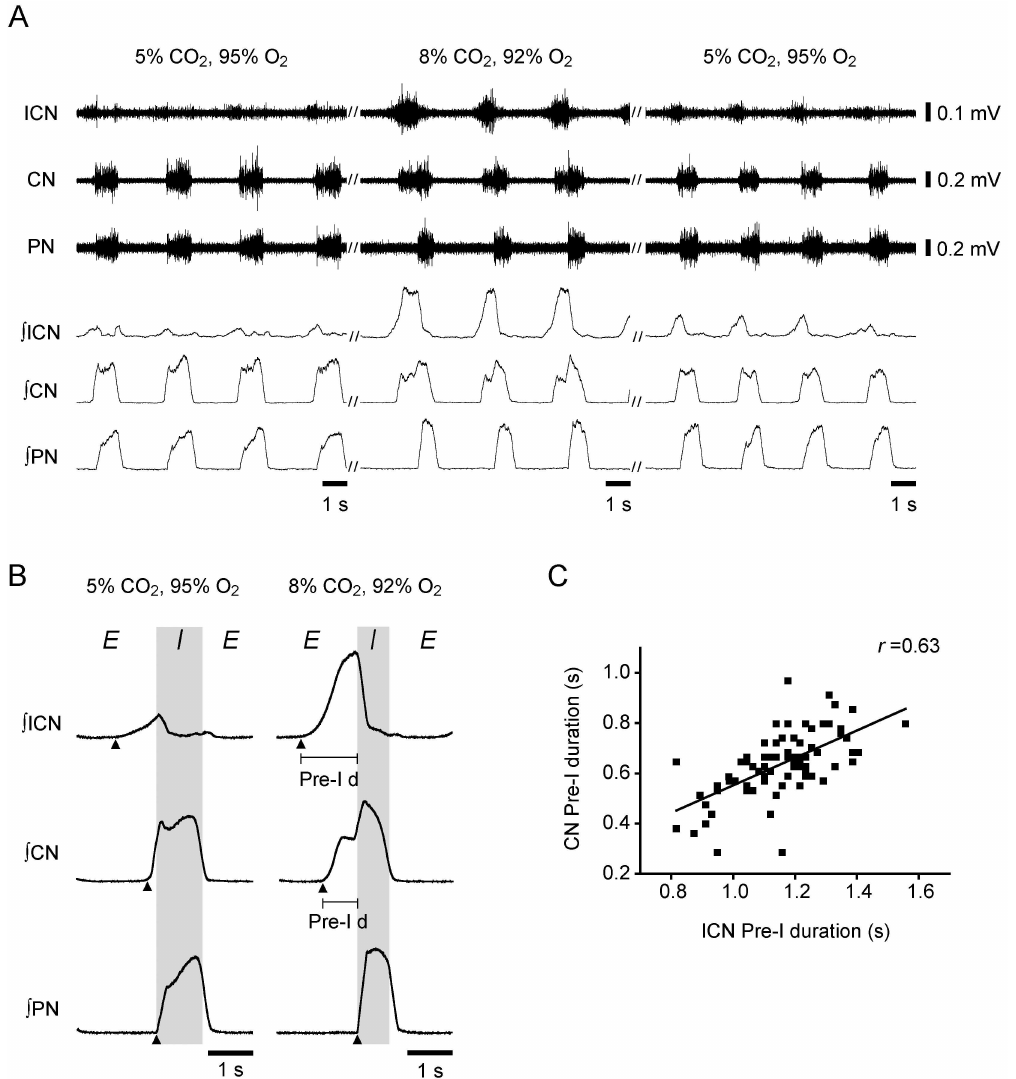
Fig 4. Comparison between intercostal nerve (ICN) activity and CN activity. (A) Originaland integratedtraces of the ICN, CN, and PN activity duringnormocapnia (5% CO 2 , 95% O 2 ), hypercapnia (8% CO 2 , 92% O 2 ), and recovery (5% CO 2 , 95% O 2 ). (B) Traces averagedfrom consecutive integratedsweepsfor 1 min in the preparation shown in (A). ‘Pre-I d’ shows the durationof pre-I dischargein the ICN and CN. The filled arrowheadsshow the onset of the nerve discharges. (C) Correlation betweenthe durationof the CN dischargein the pre-I phase and durationof the ICN dischargein the pre-I phasein the preparation shown in (A).